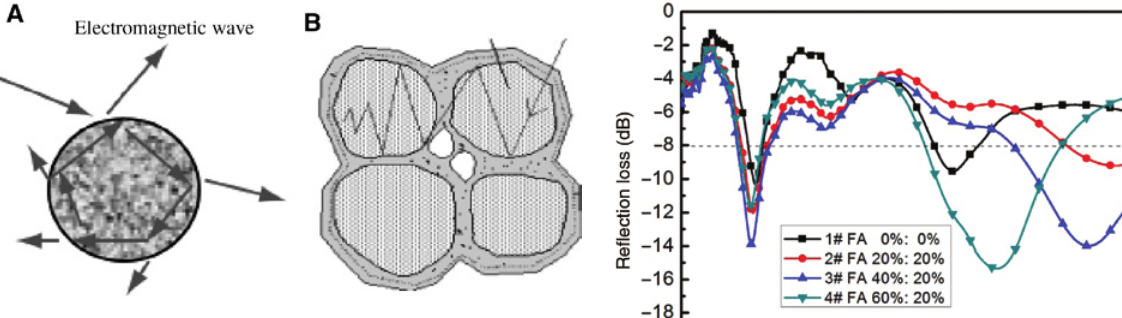
Figure 5: Reflection and scattering of the hollow spheres in FA on electromagnetic wave. (A) Single hollow sphere. (B) Multiple hollow sphere. Figure 5A and B show the phenomenon of reflection and multiple scattering of electromagnetic wave in single cavity and multiple granules. When electromagnetic wave